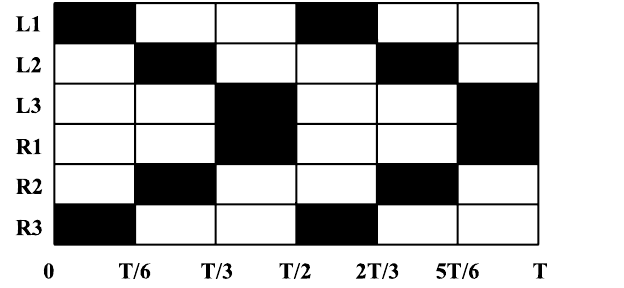
Figure 10. Sequence diagram of bipod gait.